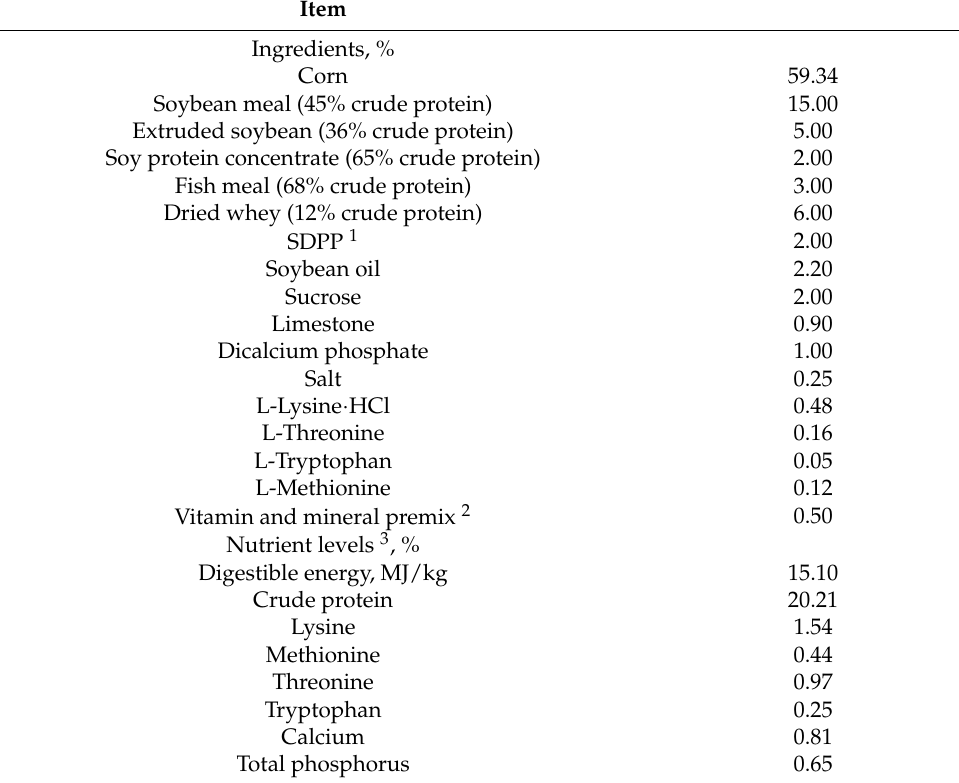
Table 1. Composition and analyzed nutrient composition of experimental diets (as-fed